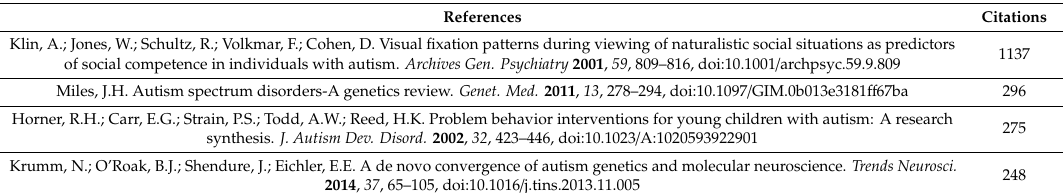
Table 9. Most cited articles on ASD-TECH.